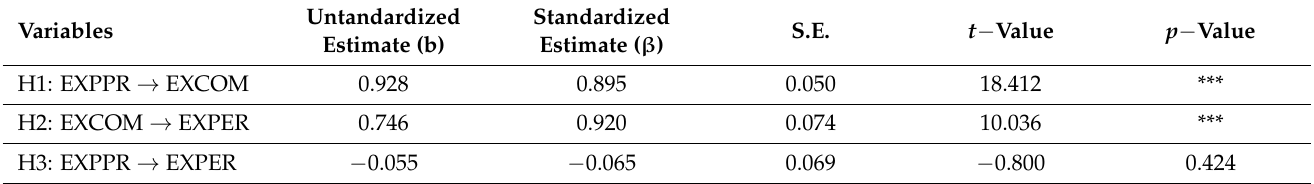
Table 3. Standardized Estimate, Unstandardized Estimate, Standard Error, t -value, z -value, and p -value.